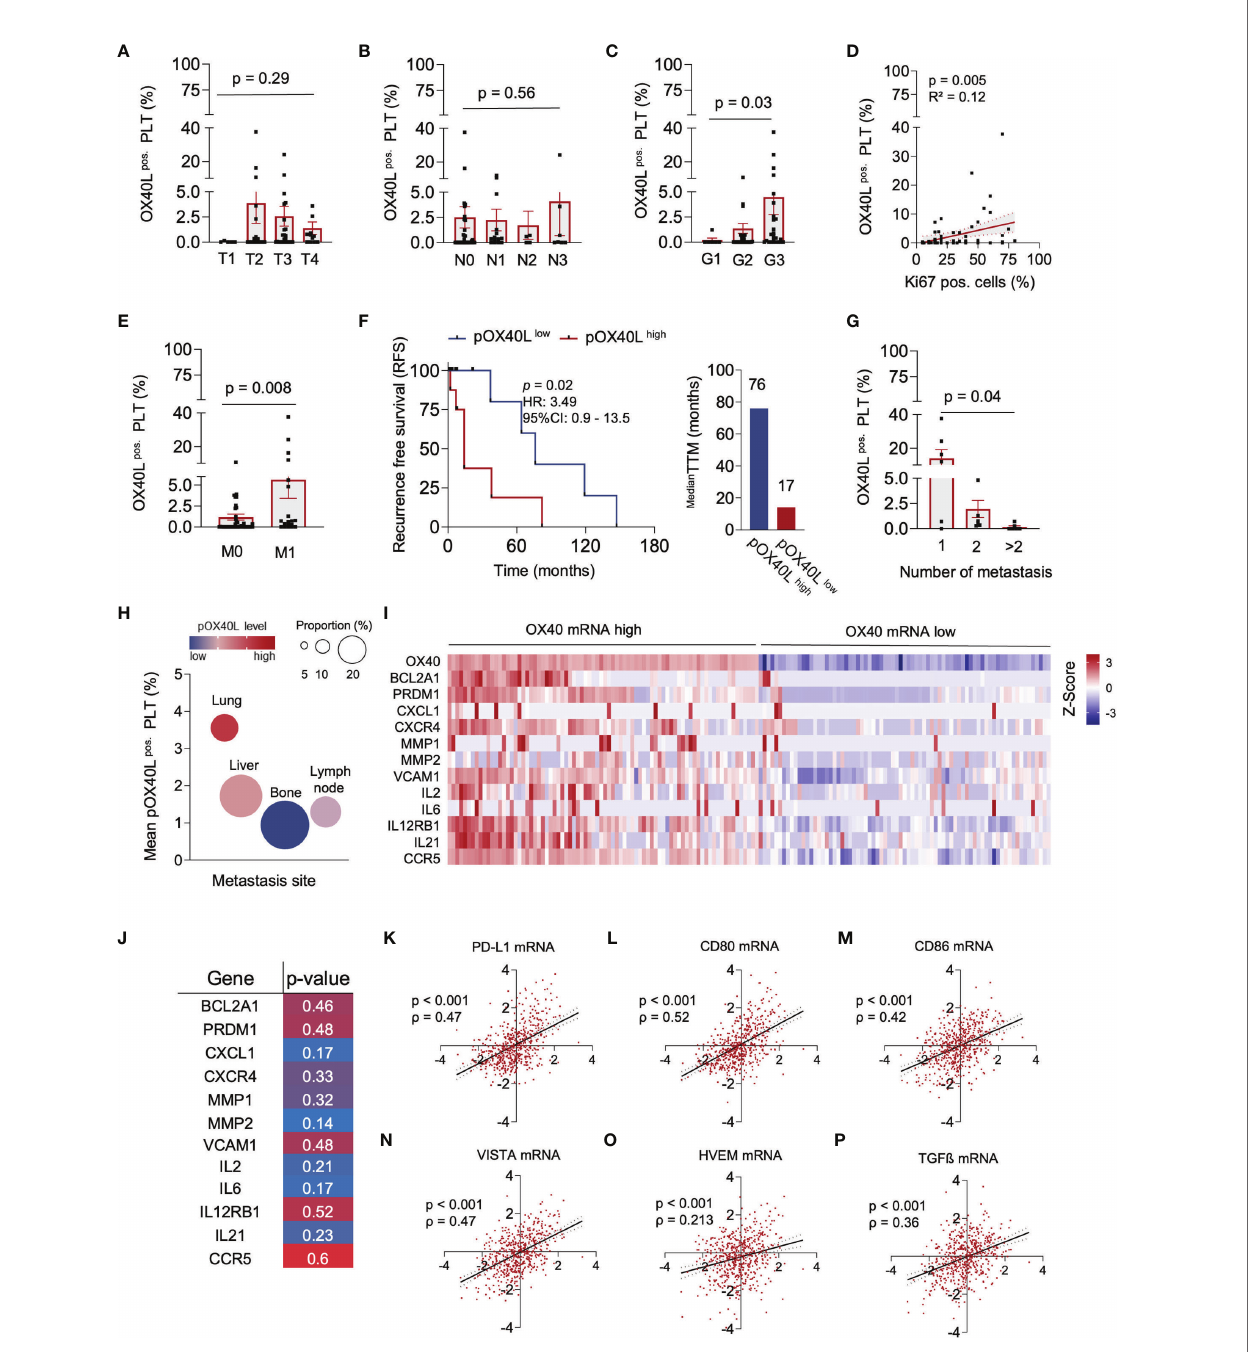
FIGURE 2 | | pOX40L predicts disease relapse and metastasis in breast cancer. (A) pOX40L expression in different tumor stages (T), (n = 65) (B) Association of pOX40L expression and lymph node invasion (N), (n = 65). (C) pOX40L level in patients with different tumor grading (G) , (n = 65). (D) Correlation between pOX40L expression on platelets of 65 BC patients and the Ki67 positive cells (%). (E) pOX40L expression in patients with and without metastatic disease (M), (n = 65). (F) Kaplan – Meier curves estimates of RFS (months) in patients with a pOX40L>mean (pOX40L high = red) and pOX40L level<mean (pOX40L low = blue), (n=65). Median time to metastasis (pOX40L high = red, pOX40L low = blue). (G) pOX40L expression in patients with different number of metastasis (n = 65). (H) Mean expression of pOX40L in different metastatic organs (n = 20). (I) Heatmap depicting the relative mRNA level OX40 and a gene set associated with lung metastasis, anti-apoptotic and tumor-promoting signatures in breast tumors (TCGA-Firehose legacy), (n = 65). (J) Spearman correlation mRNA gene signatures and OX40 mRNA. (K – P) Scatter plot of OX40 mRNA and PD-L1 ( K) , CD80 (l), CD86 (M) , VISTA (N) , HVEM (O) and TGFß (P) mRNA level in breast cancer. Each dot represents a single patient. (A – E, G, K – P) Each dot represents a single patient. (A – E, G) Data are